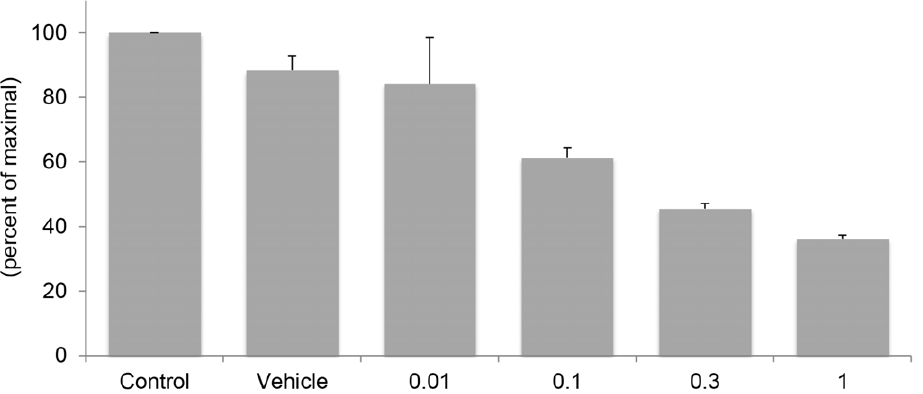
Figure 6. Ganetespib inhibits proliferation of primary human pheochromocytoma cells. Bar graphs represent cell counts of tyrosine hydroxylase (TH)-positive first passage primary human pheochromocytoma cells treated with ganetespib. Control indicates untreated cells; vehicle indicates DMSO treatment; the numbers under each bar indicate the ganetespib concentration (micromolar).